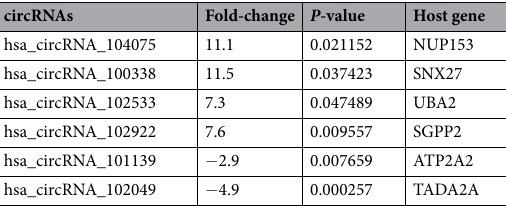
Table 1. Top six circRNAs that show differential expression in HCC compared with paired pericancerous tissues in patients.